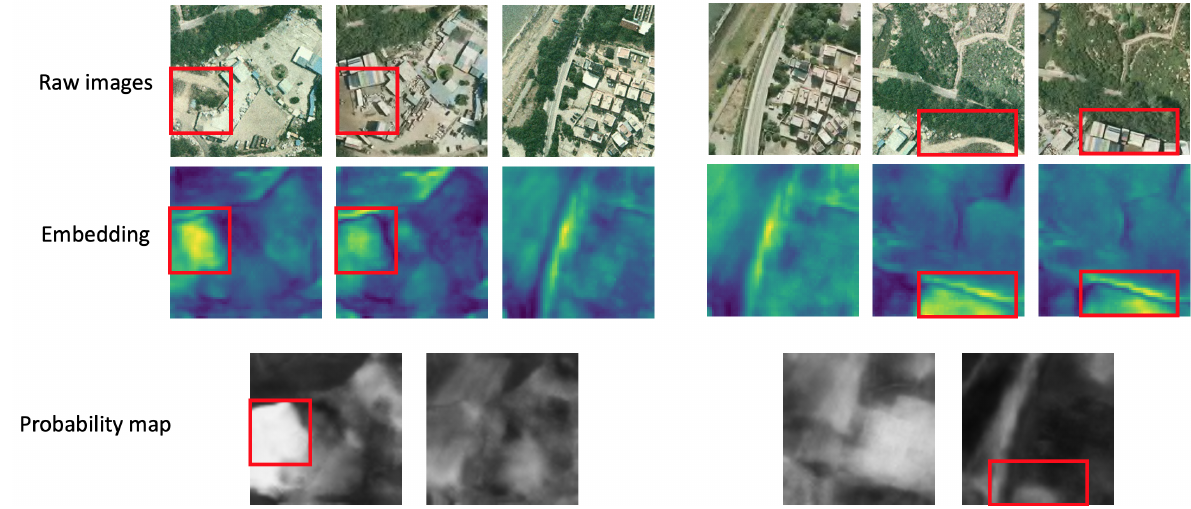
Figure 8. Embedding visualization on SYSU-CD test